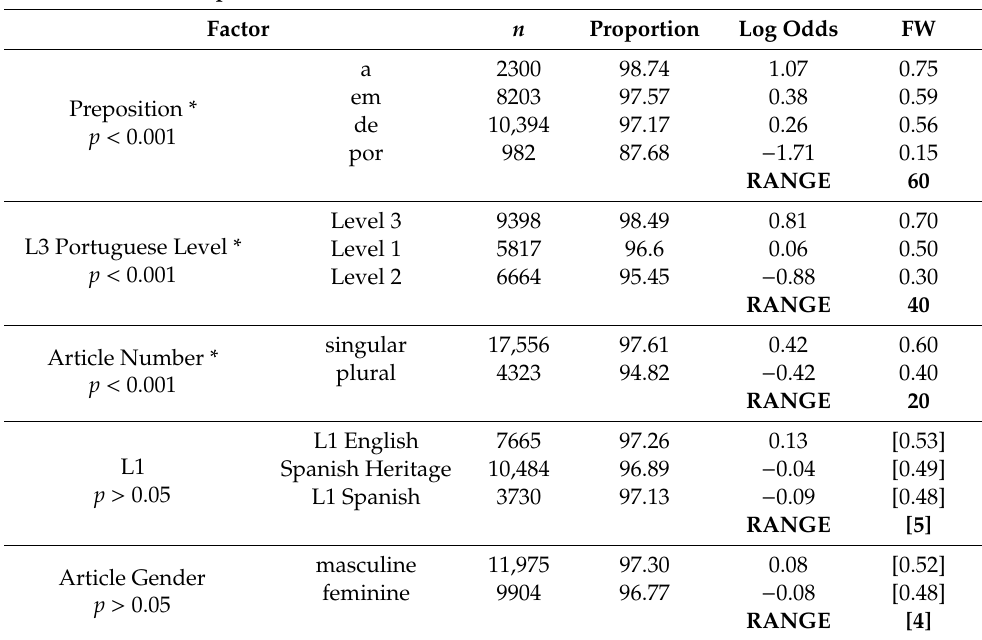
Table 8. Logistic regression of factors conditioning the realization of obligatory preposition + article contraction in L3 Portuguese in a written learners’